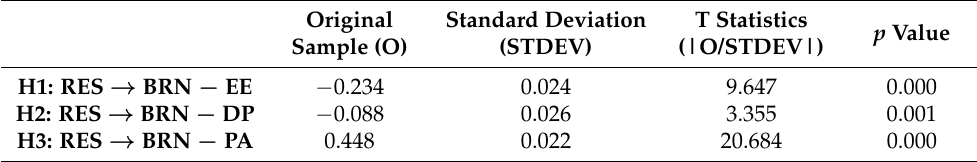
Table 5. Multiple linear regression